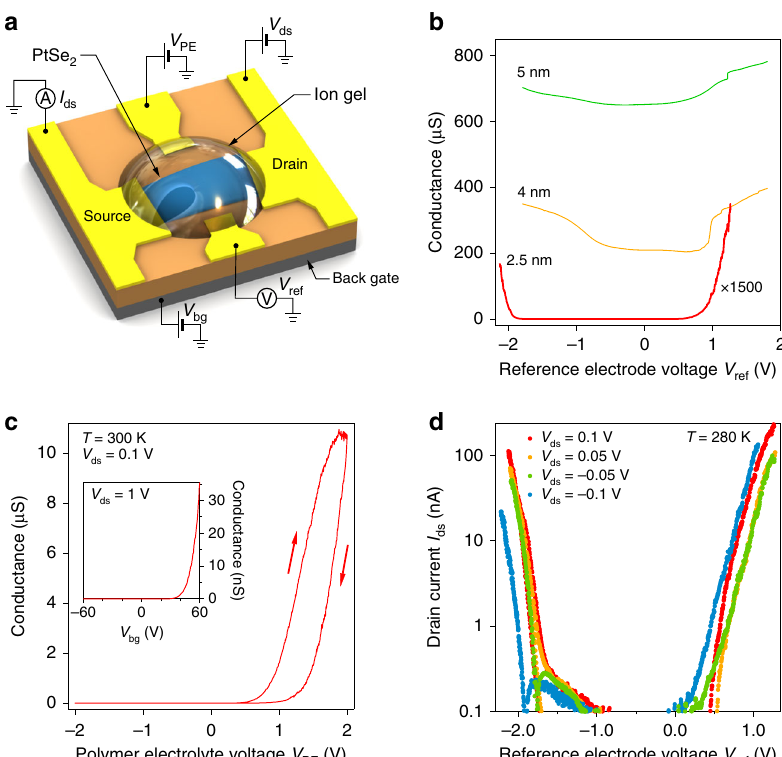
Fig. 4 Devices with ion-gel dielectrics. a Device schematic. b Conductance as a function of electrostatically induced doping. c Device conductance for the device with 2.5 nm thick PtSe 2 as a function of polyelectrolyte gate voltage V PE at 300 K. d I ds − V ref dependence for the device with 2.5 nm thick PtSe